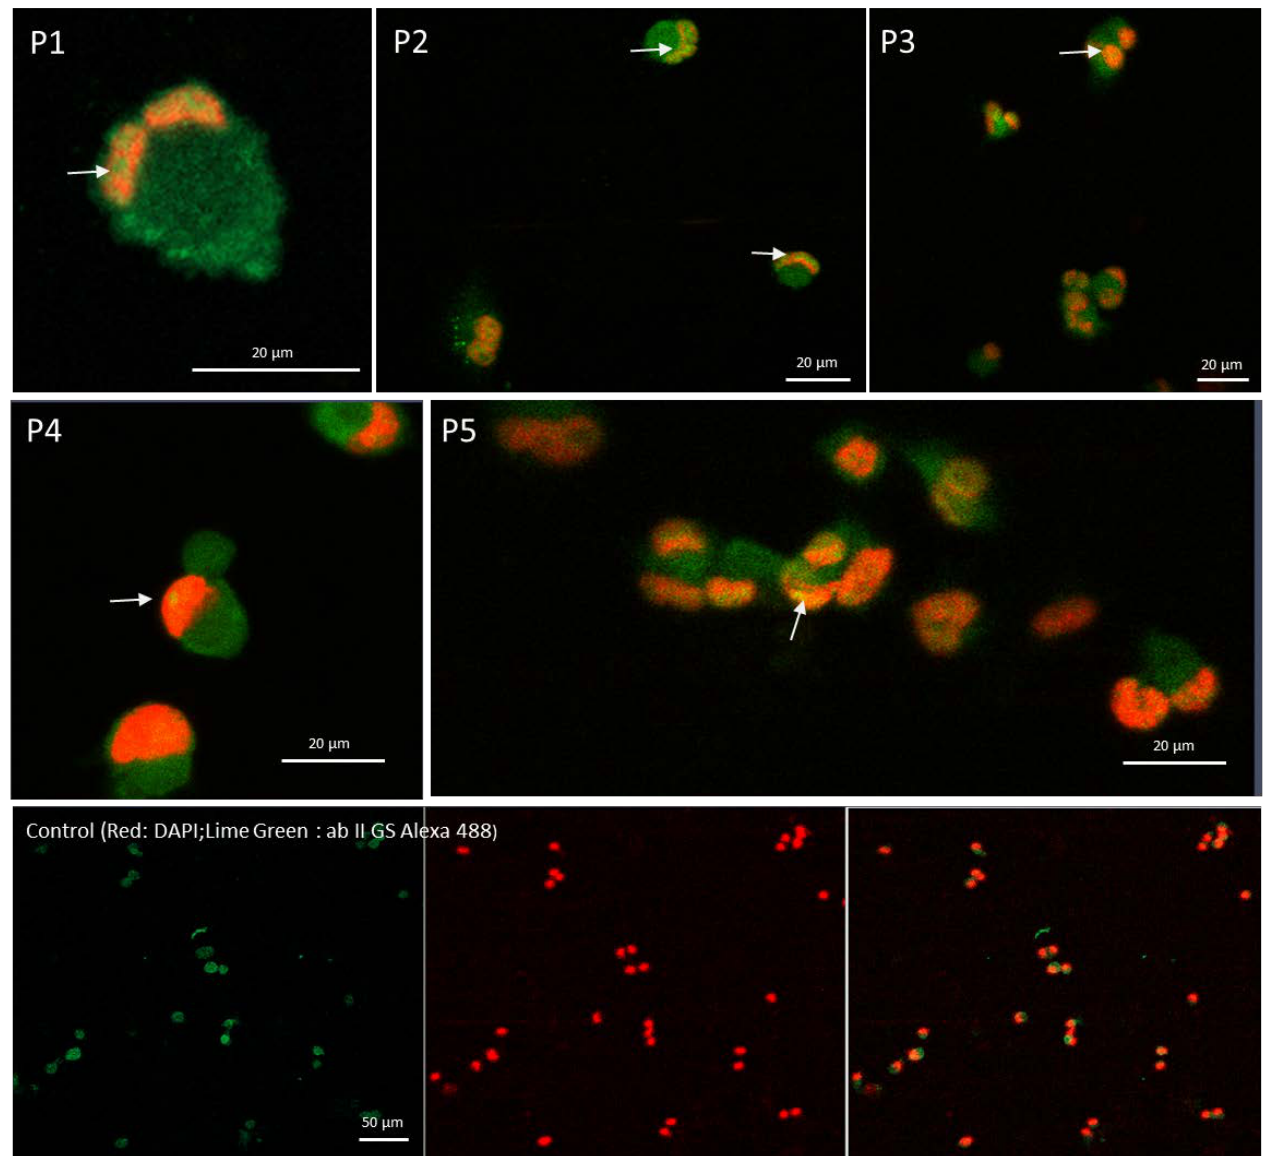
Figure 6. Confocal microscopy using fluorescent antibodies raised against STAT1. Nuclei were labeled with the DAPI staining. Red background was used for nucleus staining versus green-labeled antibody reacting with anti-STAT1. Yellow spots indicated by arrows show transfer of activated STAT1 from cytoplasm to the nucleus. At the bottom, the scale bar represents the micrometer reference of each microscopic field.